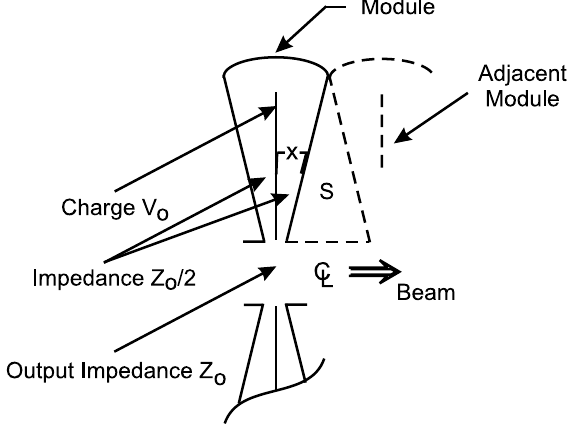
FIG. 6. ‘‘Isolated Blumlein’’ radial pulse line cavity.